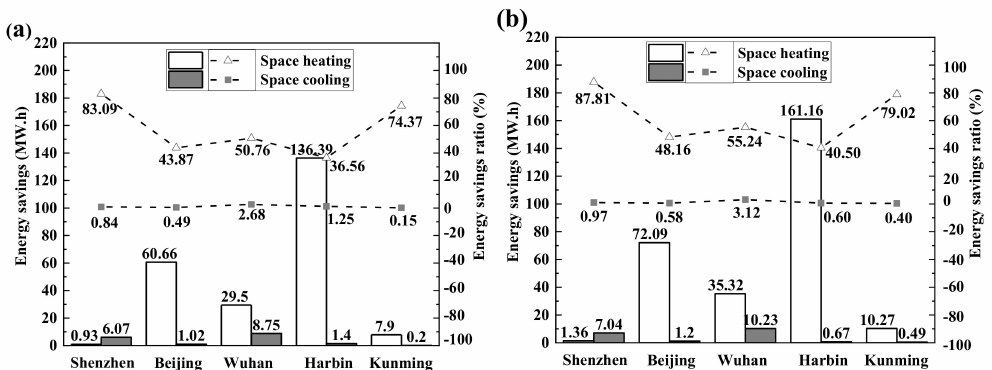
Figure 15. Space heating / cooling savings and saving ratios in di ff erent locations: ( a ) E8–G4 to E0 and ( b ) the E8–G4 to traditional